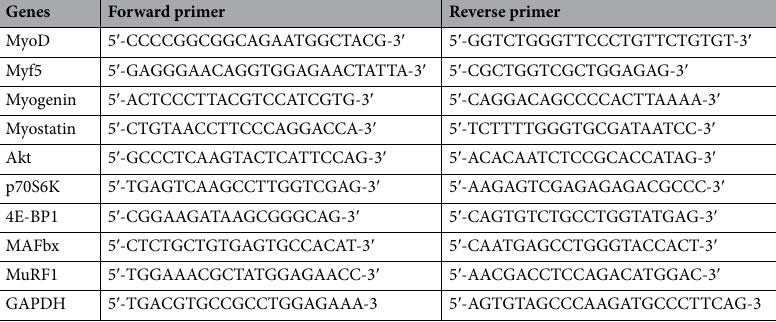
Table 1. Sequences of real-time PCR primers